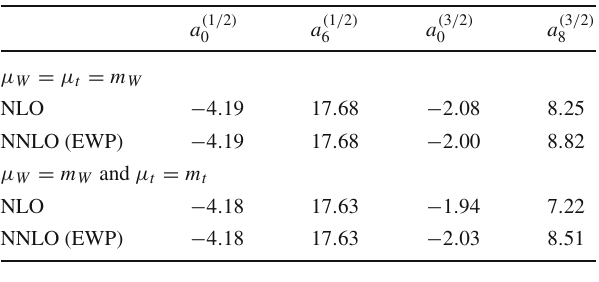
Table 1 Coefficients entering the semi-numerical formula of